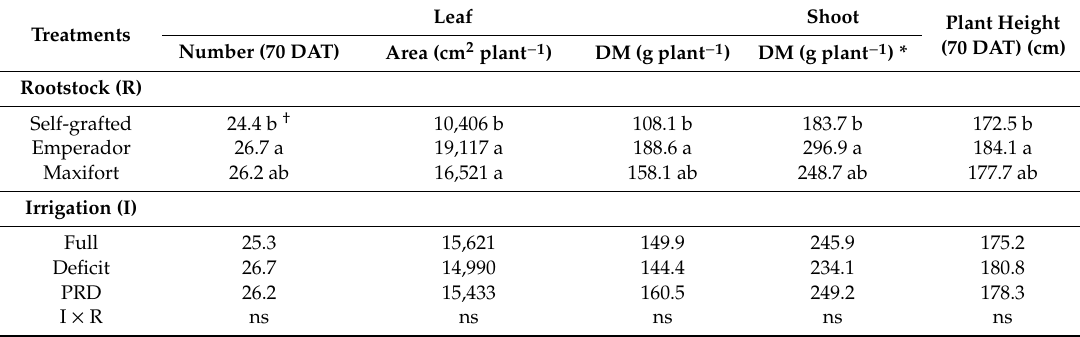
Table 1. E ff ect of rootstock type and irrigation treatment on tomato vegetative characteristics in the first year of the experiment with plants grown on one stem.